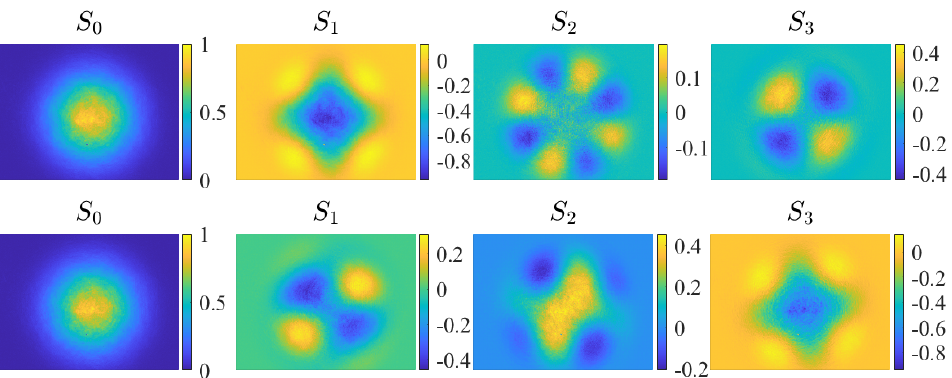
Figure 5. Stokes parameters’ maps normalized to the maximum power of the input beam. Top: input beam for all samples; Bottom: output beam in the case of a QWP with its fast axis at π /3 relative to the horizontal